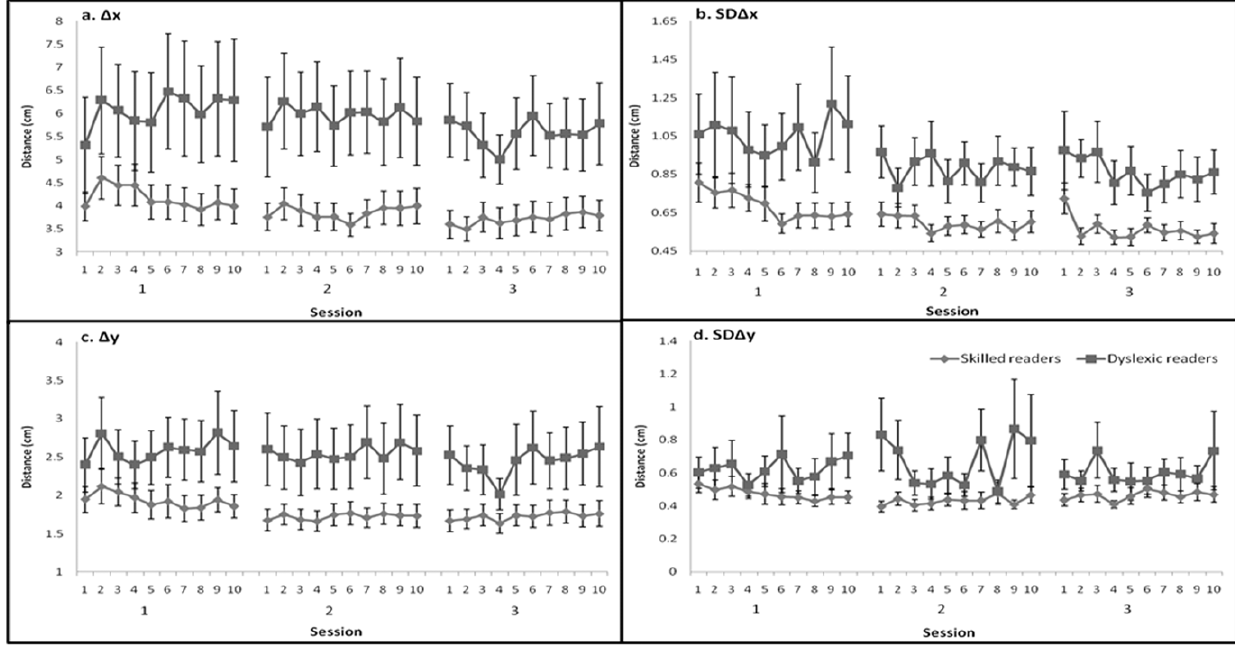
Figure 5. The posture control parameters throughout the training program in the dyslexic and skilled readers. a. D x – block mean value of the maximal amplitude of the movement of the COP in the medio-lateral direction within a given trial; b. SD D x – block standard deviation of the individual trials’ D x. c. D y – block mean value of the maximal amplitude of the movement of the COP in the anterior-posterior direction within a given trial; d. SD D y – block standard deviation of the trials’ D y. Error bars indicate group standard error.